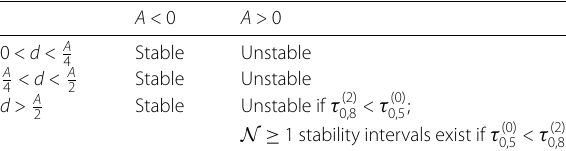
Table 1 Local stability result of the coexistence equilibrium of ring-structured system (2.2) with α = 0 and n =